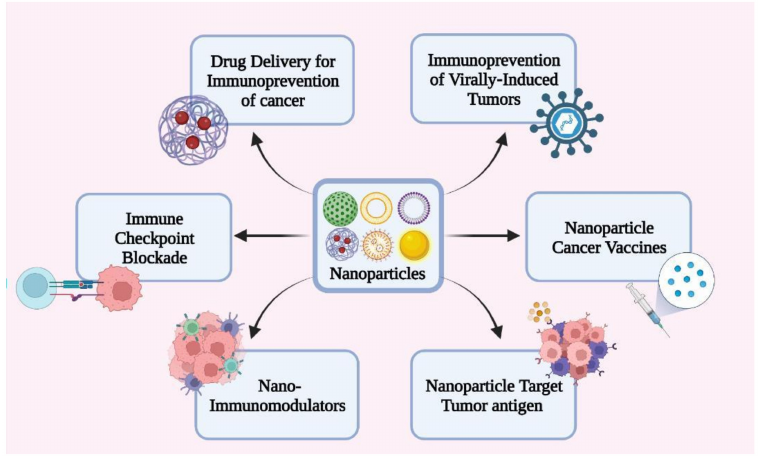
Figure 4. Applications of Nanotechnology in Cancer